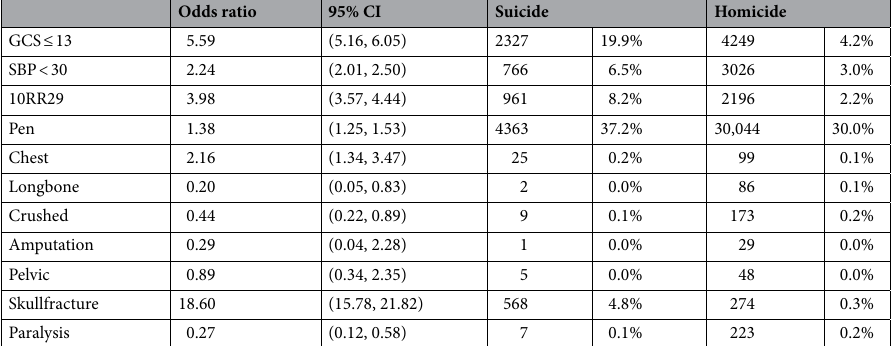
Table 3. Details and severity of injuries for homicide and suicide groups. The odds ratio (OR) and its 95% confidence interval (CI) are shown, along with the number and percent of subjects within homicide and suicide groups for each. GCS (Glasgow Coma Scale), SBP (Systolic Blood Pressure), 10RR29 (abnormal respiratory rate less than 10 or greater than 29), PEN (Penetrating